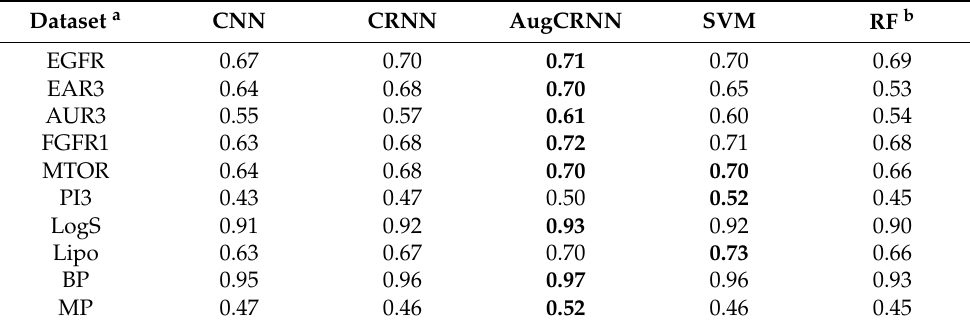
Table 2. Coefficient of determination (r 2 ) for regression datasets of drug properties.